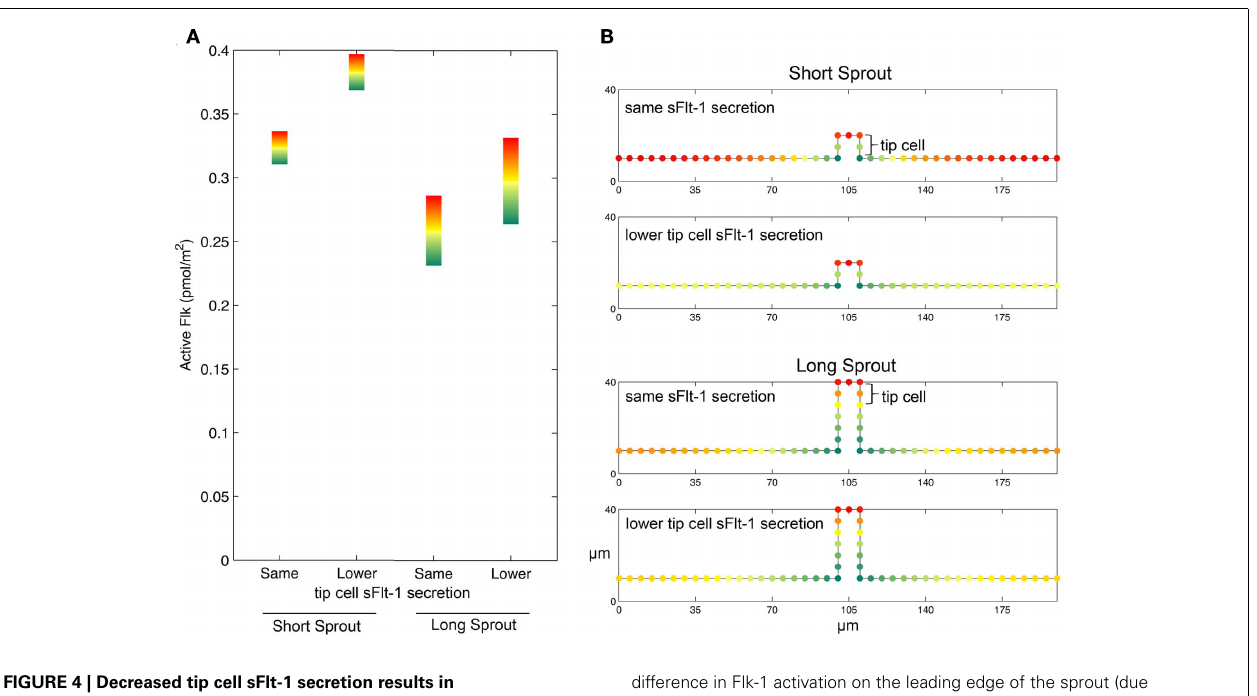
FIGURE 4 | Decreased tip cell sFlt-1 secretion results in increased Flk-1 activation on the sprout. (A,B) Active Flk-1 levels on 10 μ m long (A) or 30 μ m long (B) sprouts in which tip cell sFlt-1 secretion is the same or lower than that of base vessel cells.The